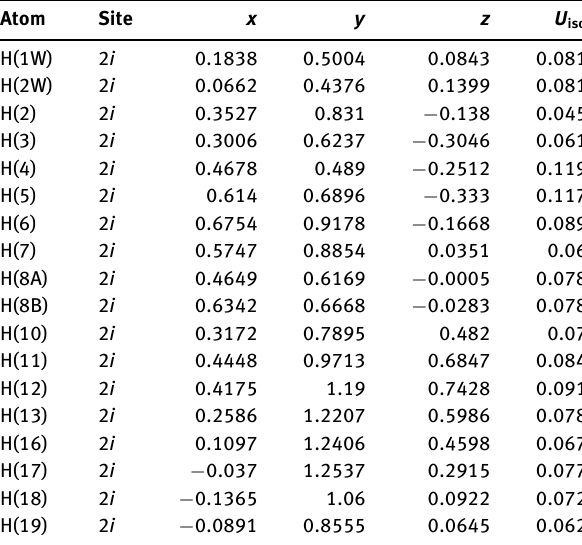
Table 2: Fractional atomic coordinates and isotropic or equivalent isotropic displacement parameters (Å 2